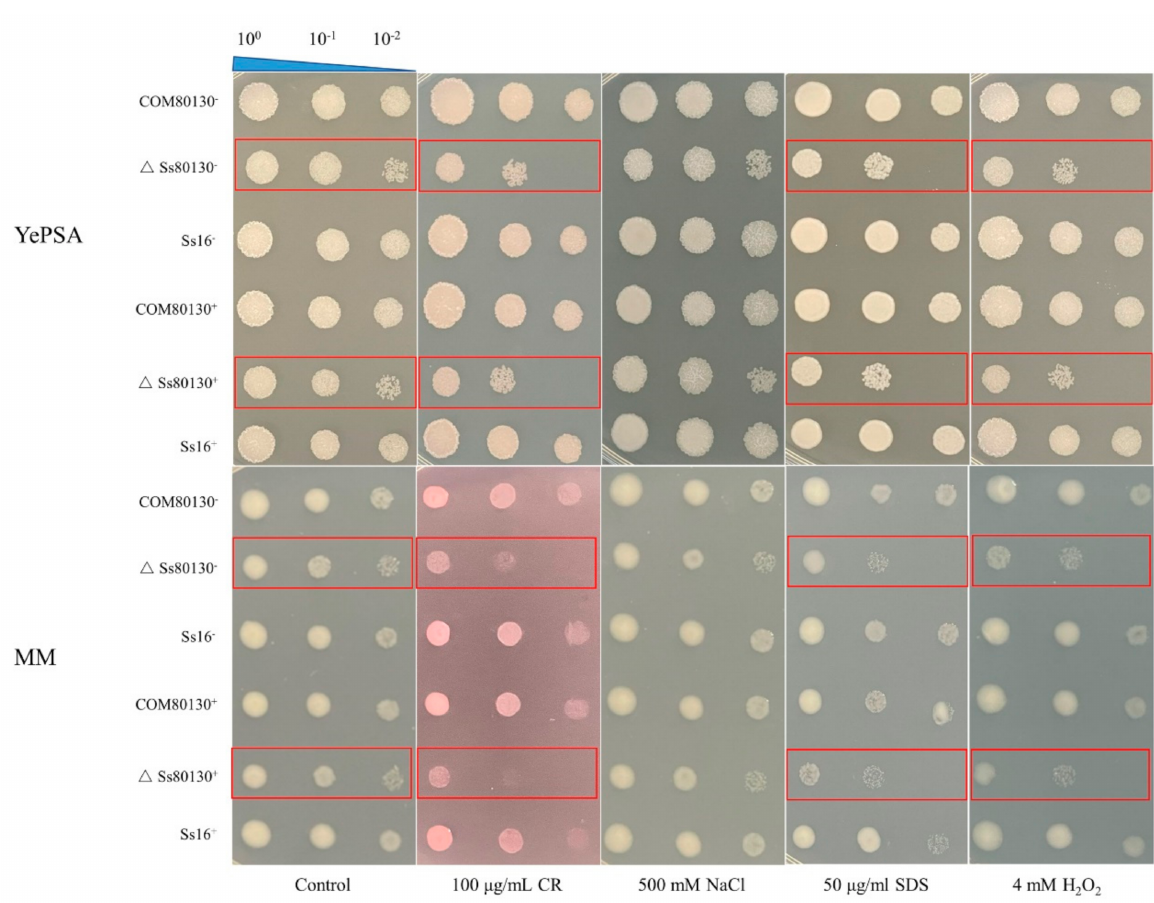
Figure 7. Effects of the SsCI80130 gene on abiotic stress in S. scitamineum . Serially diluted sporidia of the wild type ( Ss16 + and Ss16 − ), knockout mutants ( ∆ Ss16 + and ∆ Ss16 − ), and complementary mutants ( COM80130 + and COM80130 − ) were spotted on YePSA plates and MM plates supplemented with Congo red (CR) (100 µ g/mL), NaCl (500 mM), SDS (50 µ g/mL), or H 2 O 2 (4 mM). Samples were cultured at 28 ◦ C for 48 h before photographing. Changes in growth of knockout mutants are marked with red